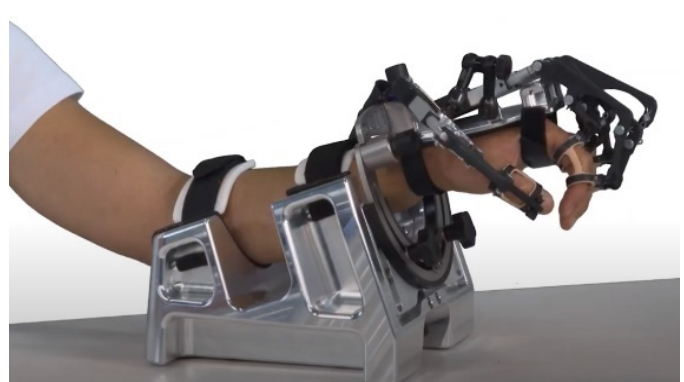
Figure 1. The RobHand hand exoskeleton and the forearm support.